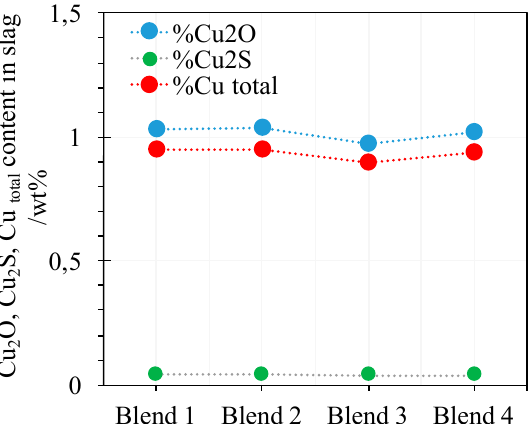
Figure 4. Process balance results: Cu 2 O, Cu 2 S, and Cu dissolved in the slags generated by smelting of each blend.